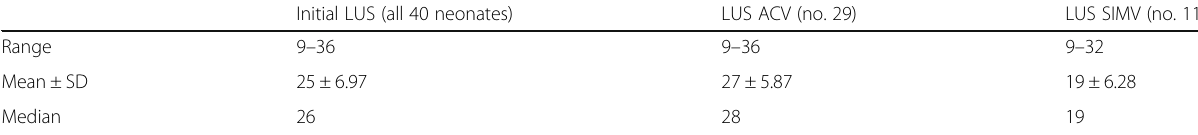
Table 1 Showing their initial lung ultrasound score for neonates at the time of admission Initial LUS (all 40 neonates)